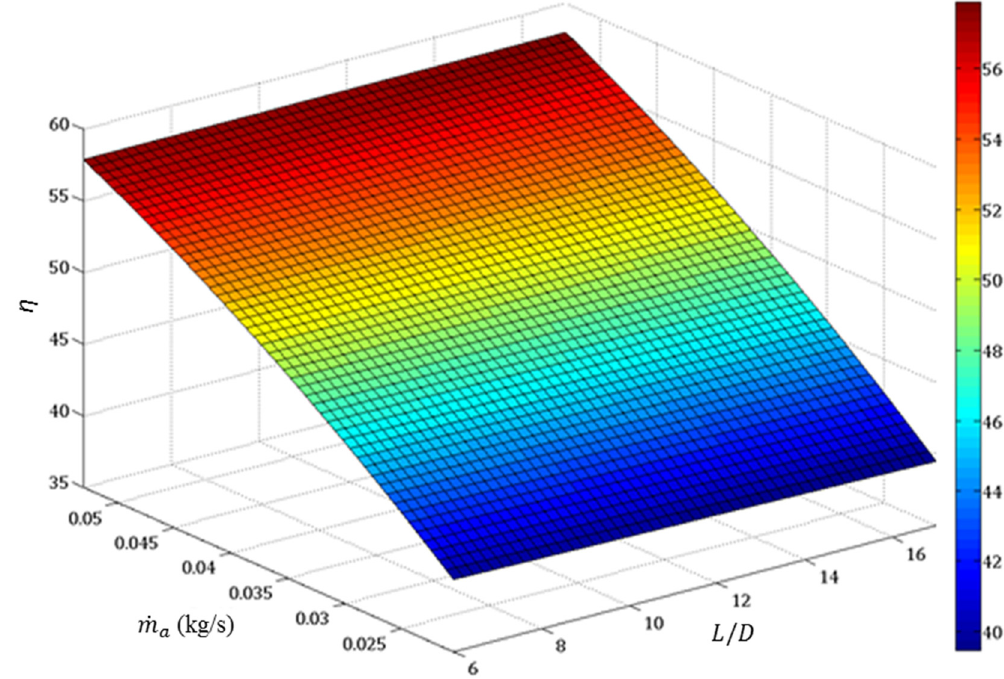
Figure 10. Cooling tower efficiency based on packing compaction and air flow rate.